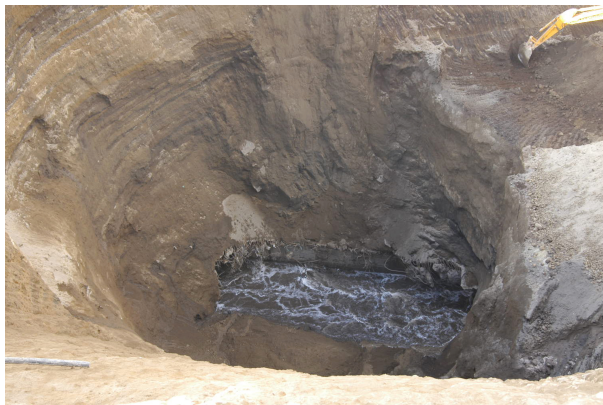
Figure 4. View into the sinkhole with the appearance of the Machángara River at its